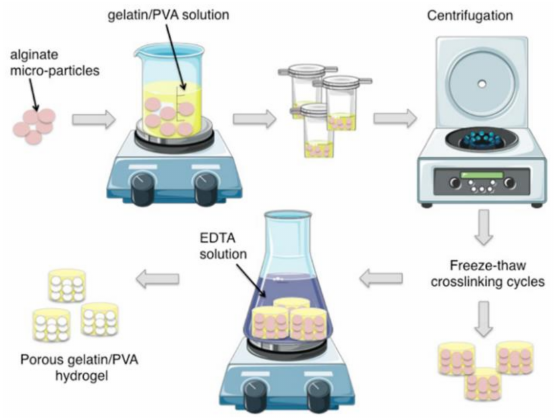
Figure 2. Schematic representation of the fabrication process of gelatin/polyvinyl alcohol (PVA) porous